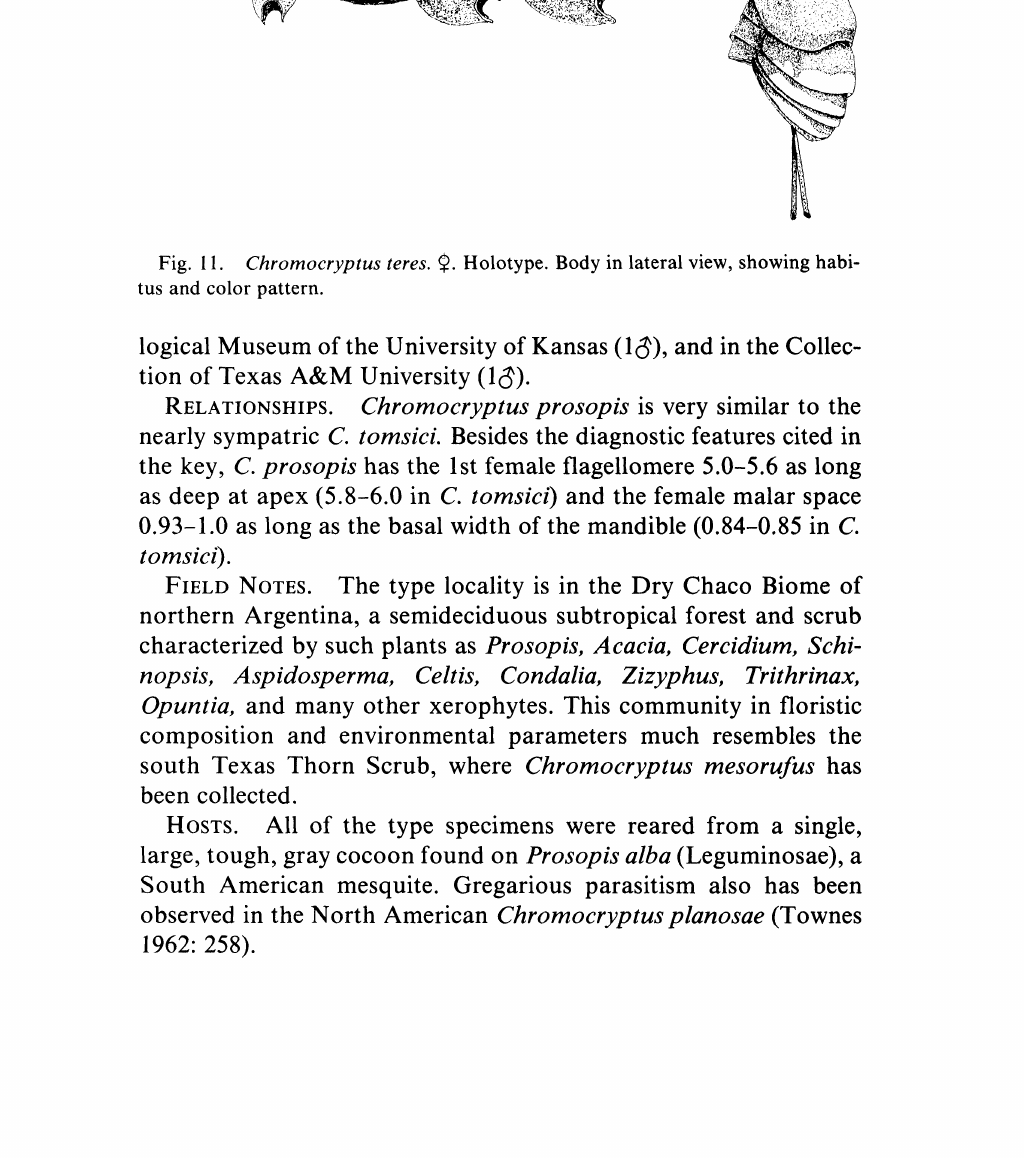
.. Holotype. Body in lateral view, showing habi-